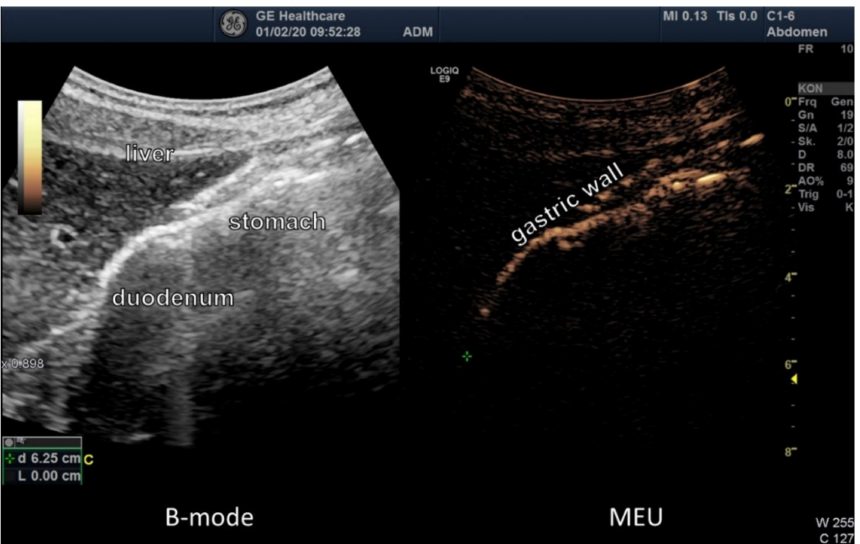
Figure 3. Ultrasound image of the stomach. B-mode after ingestion of the mixture with vitamin C, the substance was immediately detected as an echo amplification by ultrasound in the stomach. The microbubbles (MEU) migrated to the stomach wall and are clearly